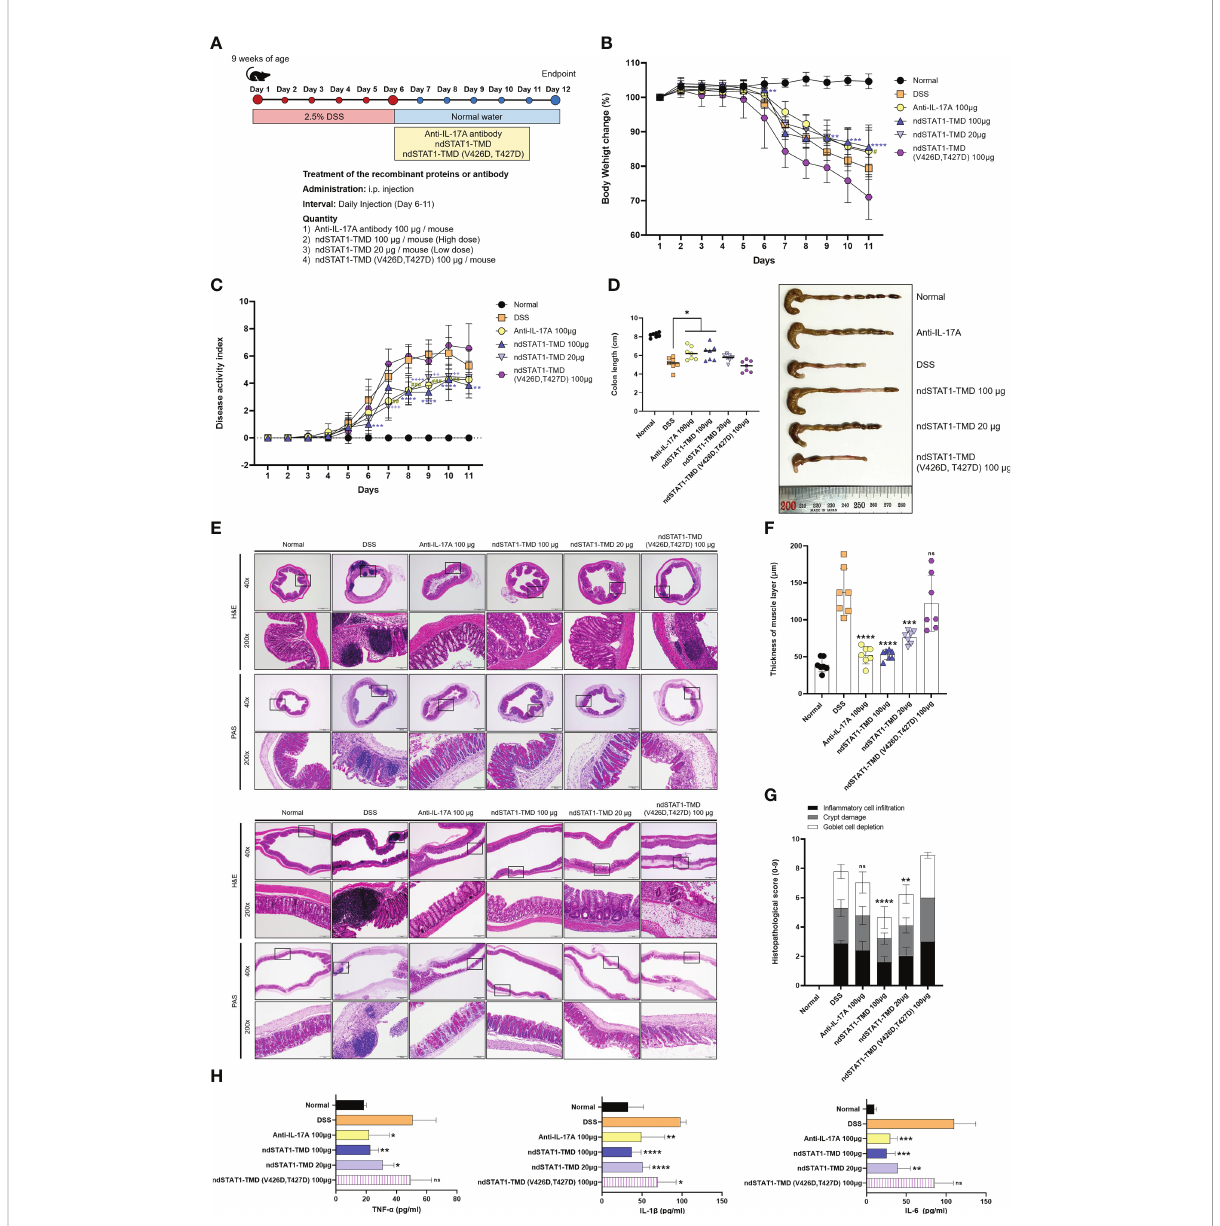
FIGURE 7 ndSTAT1-TMD alleviates the disease progression of DSS-induced colitis. (A) The treatment scheme of 2.5% DSS-induced colitis mice with PBS (DSS group), anti-IL-17A antibody (100 m g/mouse), ndSTAT1-TMD (20 m g/mouse or 100 m g/mouse), or ndSTAT1-TMD (V426D, T427D) (100 m g/ mouse). (B) Body weight change of each treated group. (C) Disease activity index (DAI) score of each treated group. DAI score was calculated by measuring the clinical score of stools, fecal occult blood, and body weight change in each group. #p<0.05; **,##,++p<0.01; ***,###, +++p<0.001; ****,++++p<0.0001. * DSS and ndSTAT1-TMD 100 m g; # DSS and anti-IL-17A antibody 100 m g, + DSS and ndSTAT1-TMD 20 m g. (D) Left panel: Comparative analysis of the colon lengths of mice in each treated group on day 12. *p<0.05. Right panel: Representative image of colons from (A) . (E) Representative vertical (above panel) and horizontal (below panel) colonic sections from (D) were stained with H&E or PAS. Scale bar represents 500 m m for 40X and 100 m m for 200X. (F) The thickness of the muscle layer of colons in each treated group was measured from (E) images. ***p<0.001, and ****p<0.0001. (G) Histopathological scores are calculated by in fl ammatory cell in fi ltration, crypt damage, and goblet cell depletion. The graph is represented as mean ± SEM (n=6). ns, not signi fi cant, **p<0.01, and ****p<0.0001. (H) The level of pro-in fl ammatory cytokines (TNF- a , IL-1 b , or IL-6) in the serum of each treated group was measured by ELISA. The graphs are represented as mean ± SEM (n=5). ns, not signi fi cant, *p<0.05, **p<0.01, ***p<0.001, and ****p<0.0001. The experiments in the IBD model were independently performed twice times. The graphs in (B-D, F) are represented as mean ± SEM (n=7). Statistical analysis was examined using Student ’ s t-test or ANOVA analysis followed by Dunnett ’ s multiple comparison test, and in the case of graph (G) , statistical signi fi cance was shown when the histopathological score was lower than that of the DSS